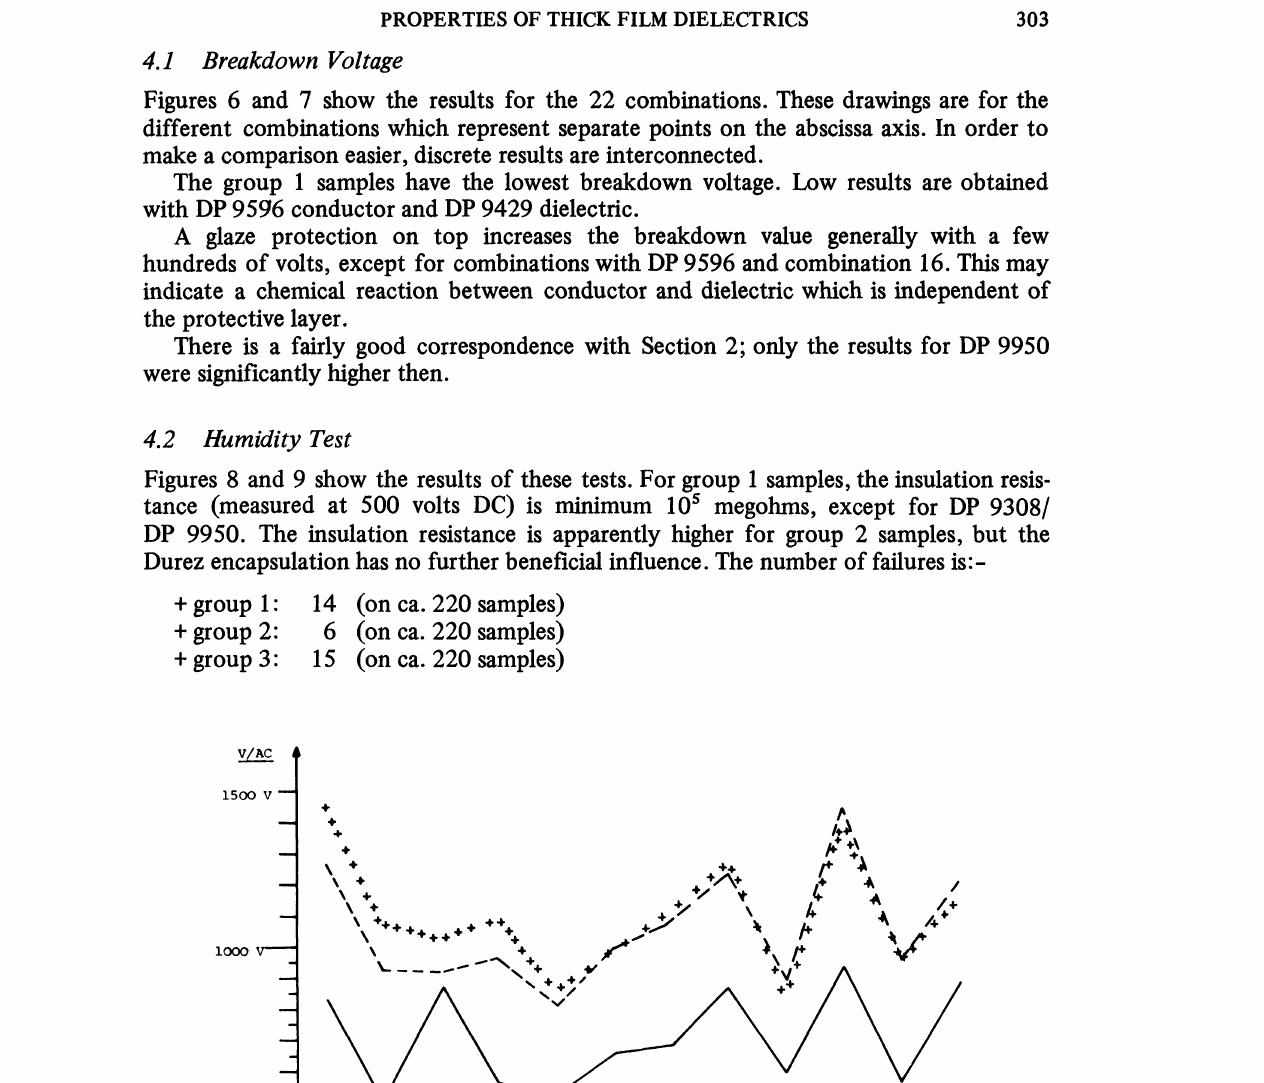
Breakdown voltage of various materials, no glaze, no encapsulation, glaze DP 9137, no encapsulation, ++++++ glaze DP 9137, encapsulation Durez